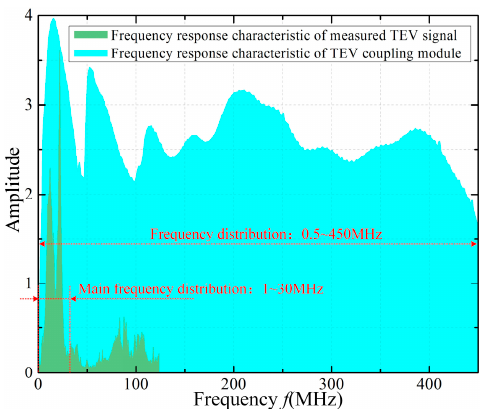
Figure 8. Frequency response of the measured TEV signal and TEV coupling module.